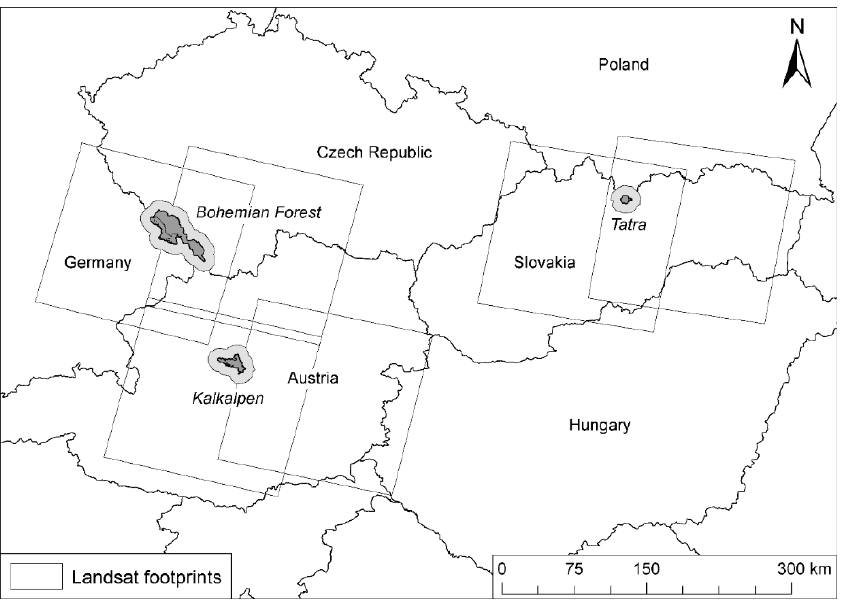
Figure 1. Location and extent of the three study sites. Dark gray areas represent initial protected area polygons and light gray areas the constructed buffer zones.